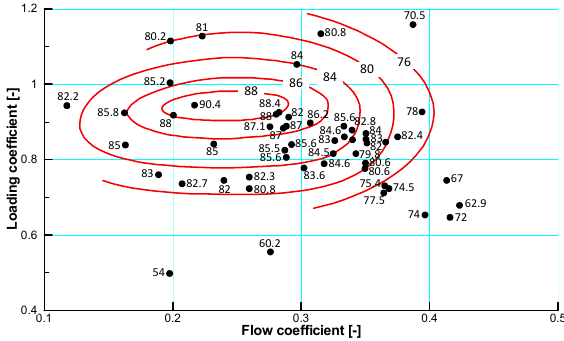
Figure 2. Correlation of loading and flow coefficients for radial inflow turbine [26,28].